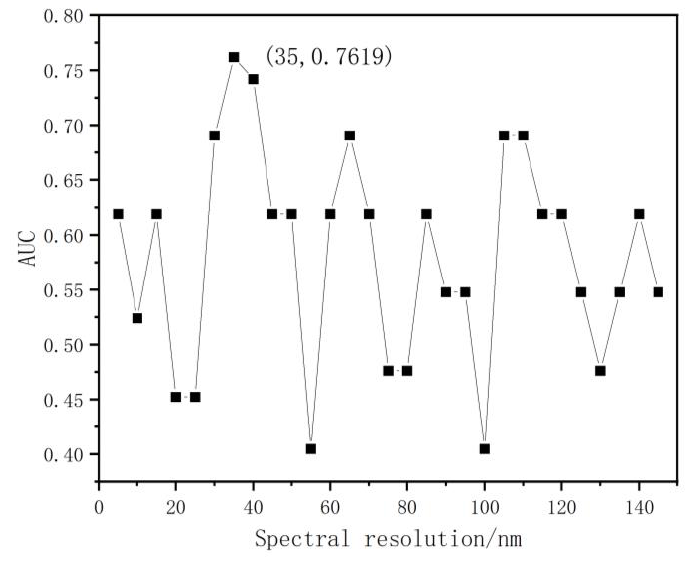
Figure 10. Selection of the optimal spectral resolution.